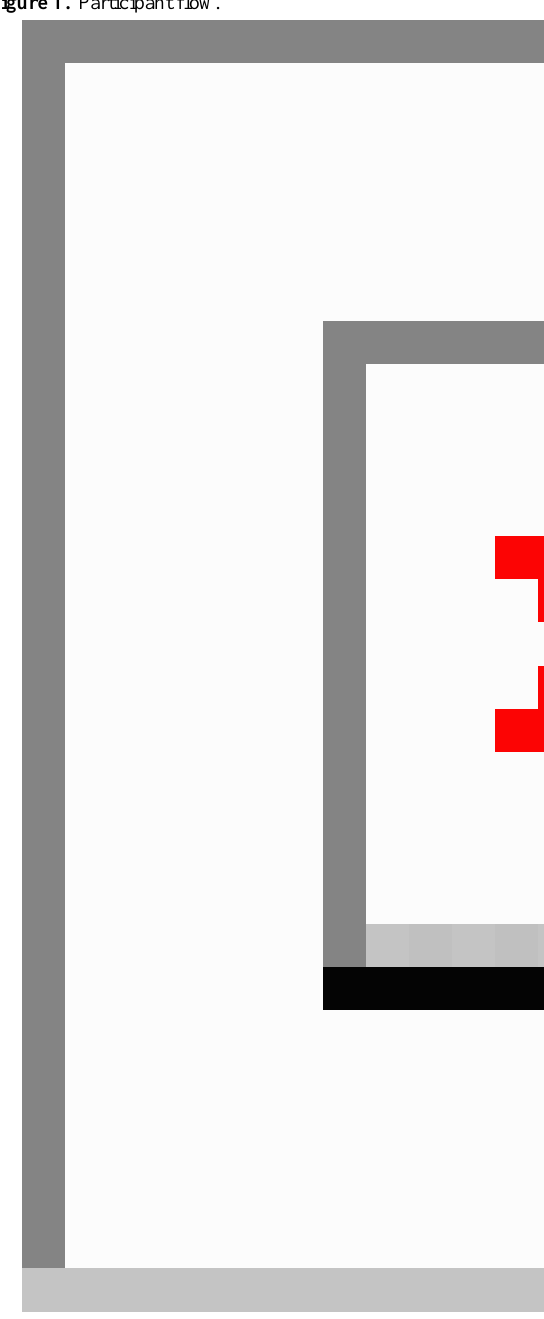
Figure 1. Participant